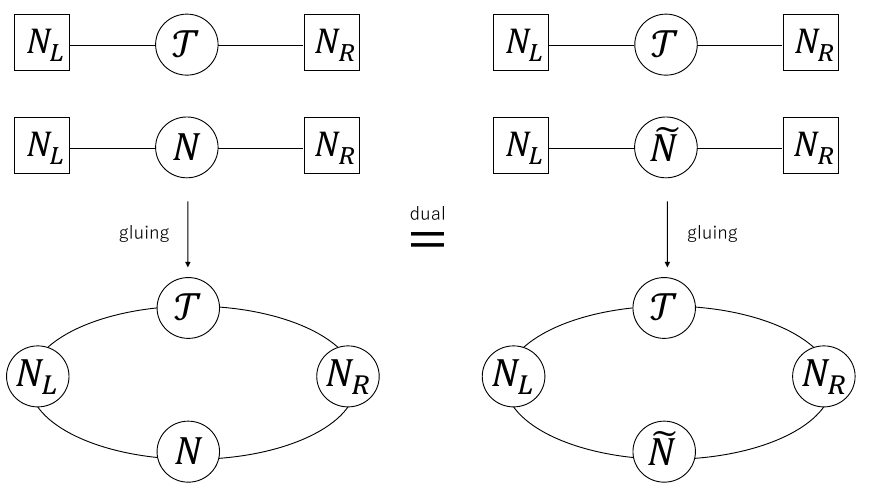
Figure 10 . Illustration of generating new dualities when the local theory has a Lagrangian. The duality of the local theory implies new dualities by gluing theories with the common flavor symme- tries. Gluing the two theories with two common flavor